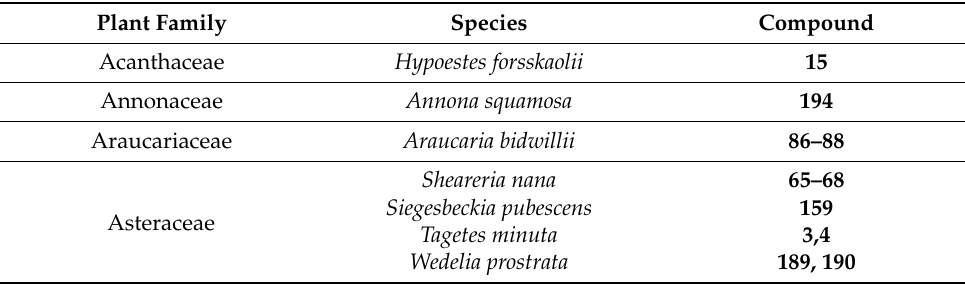
Table 3. Plant families and isolated